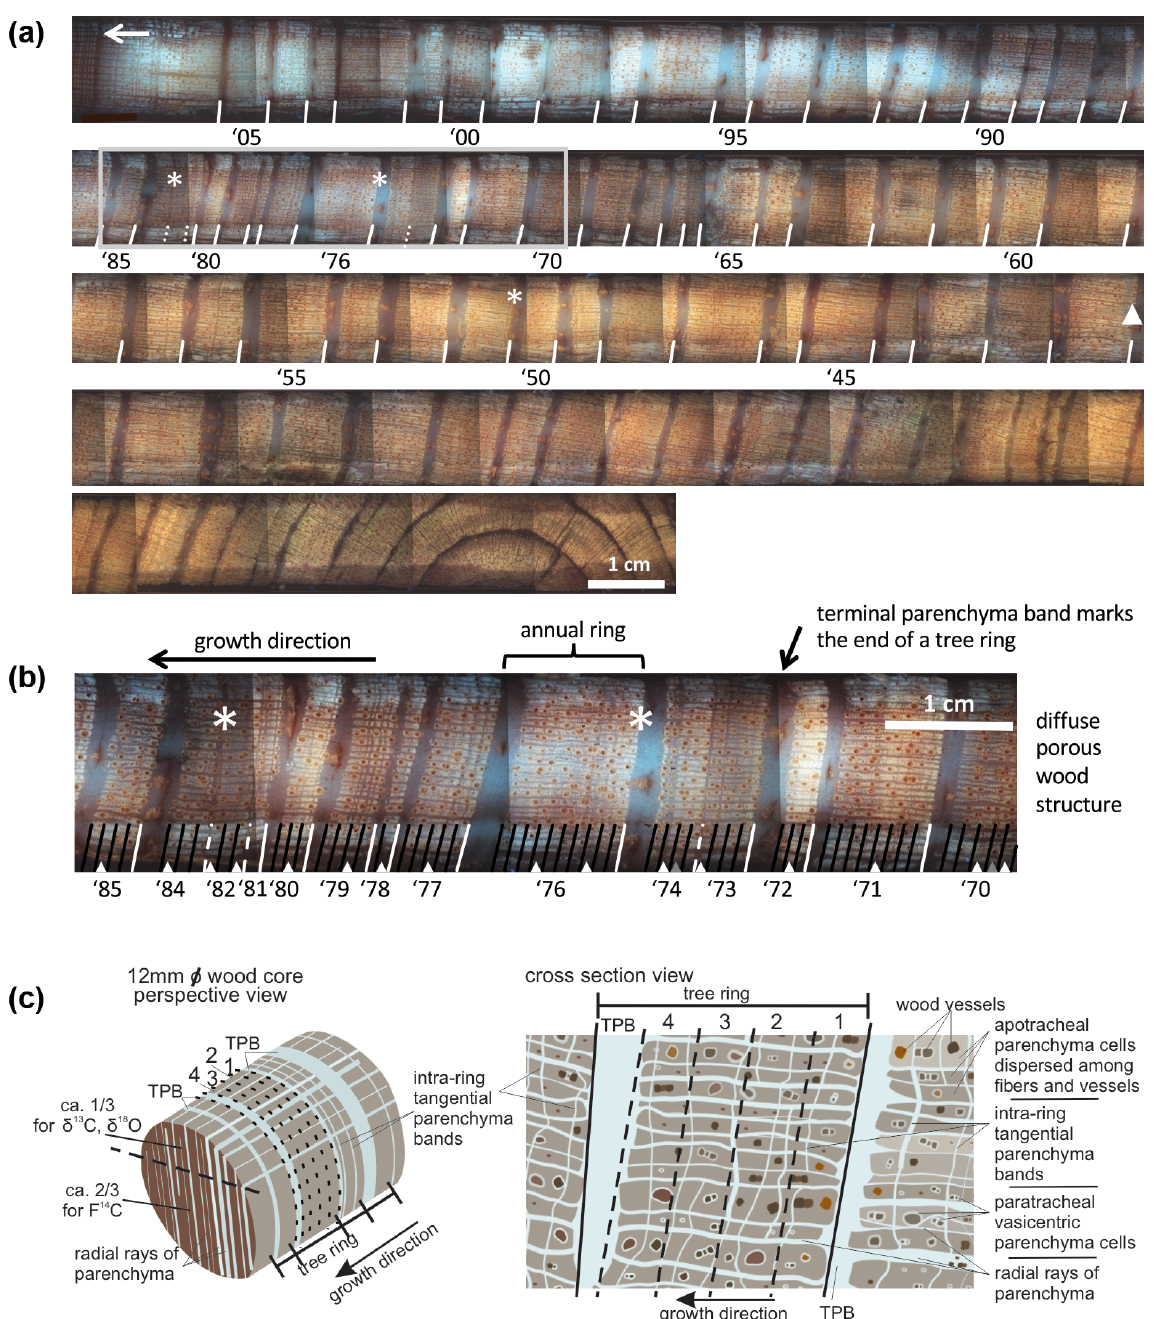
Figure 2. Wood anatomy of the sampled baobab core. The right side of each photograph is unintentionally darker, causing vertical cutoffs in the stitched panorama. White asterisks mark positions of missing rings identified by radiocarbon dating. (a) Stitched core picture pho- tographed under ultra-violet light with automatic white balance showing alternating diffuse porous wood sections and clearly defined terminal parenchyma bands. Tree-ring boundaries and years of growth are indicated for the analyzed core section, i.e., from cambium (white arrow, top left) until 1941 (white triangle). (b) Enlarged core section (grey frame on top) with indicated tree-ring boundaries (white lines), intra- annual subsamples (black lines), radiocarbon-dated samples (white triangles: holocellulose; grey triangles (1970, 1974): alpha cellulose) and years of growth. Boundaries indicated by dashed white lines were only identified after additional 14 C analyses. (c) Schematic drawing of an increment core section indicating the high abundance of radial and tangential parenchyma bands. Tree rings end with a terminal parenchyma band (TPB); however, they also contain intra-annual tangential parenchyma bands of various thicknesses. Intra-annual tangential slices of ca. 1mm thickness were dissected with a scalpel (dashed lines). Two-thirds of each slice was kept for F 14 C, and one-third was used for stable isotope analysis. (d) Schematic drawing of a cross-section view illustrating different peculiarities of parenchyma tissue in baobabs (parenchyma cells dispersed among wood fibers and vessels not shown). For details, see